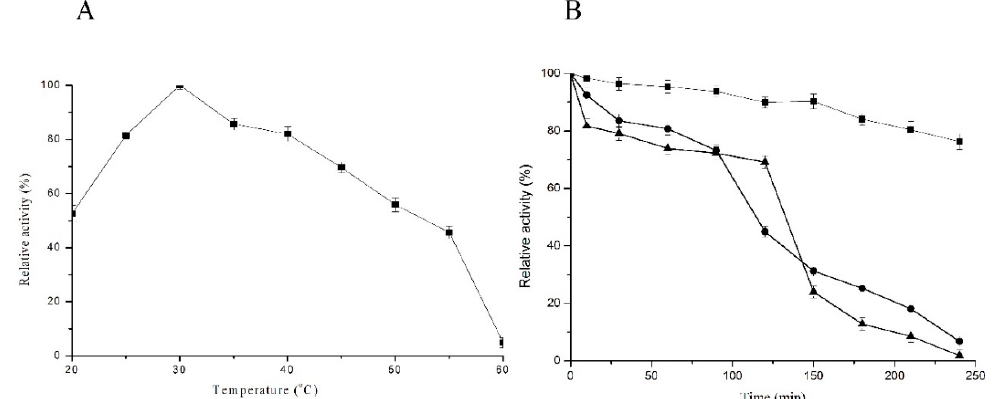
Figure 3. Optimum temperature and temperature stability of C12O from Pc UFB2. ( A ) 0.13 µg of enzyme incubated at a different temperatures and the activity was measured at optimum pH (7.5); ( B ) The temperature stability of C12O at 30 °C ( ■ ), 50 °C ( ● ), and 70 °C ( ▲ ).